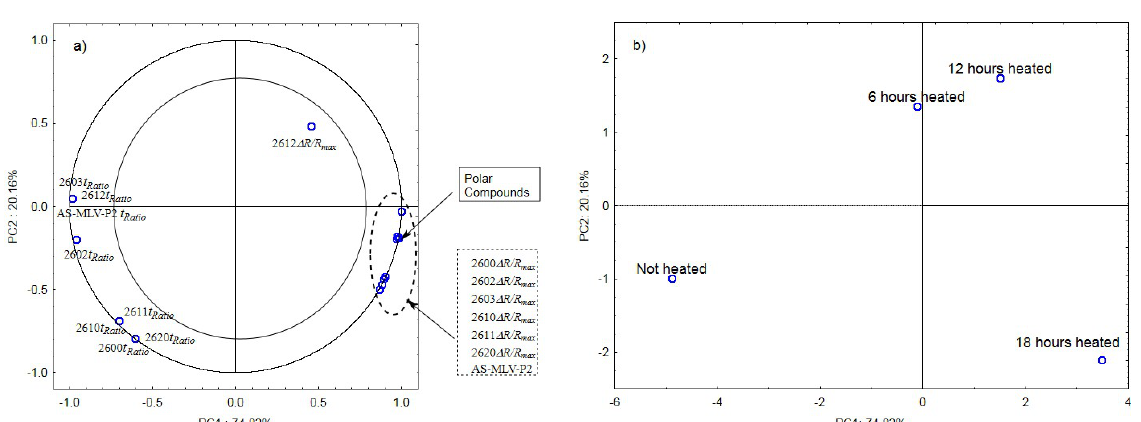
Figure 3. ( a )—Plot of two principal component loadings (PC1, PC2) from eight sensor readings and polar compounds obtained for heated (0.378 s/v ratio) and control oil samples ( ∆ R/R max , t Ratio ; AS brief names of sensors—AS-MLV-P2; 2600, 2602, 2603, 2610, 2611, 2612, 2620—brief names of sensors Figaro—TGS series); ( b )—Plot of two principal component scores (PC1, PC2) from eight sensor readings and polar compounds obtained for heated (0.378 s/v ratio) and control oil samples.